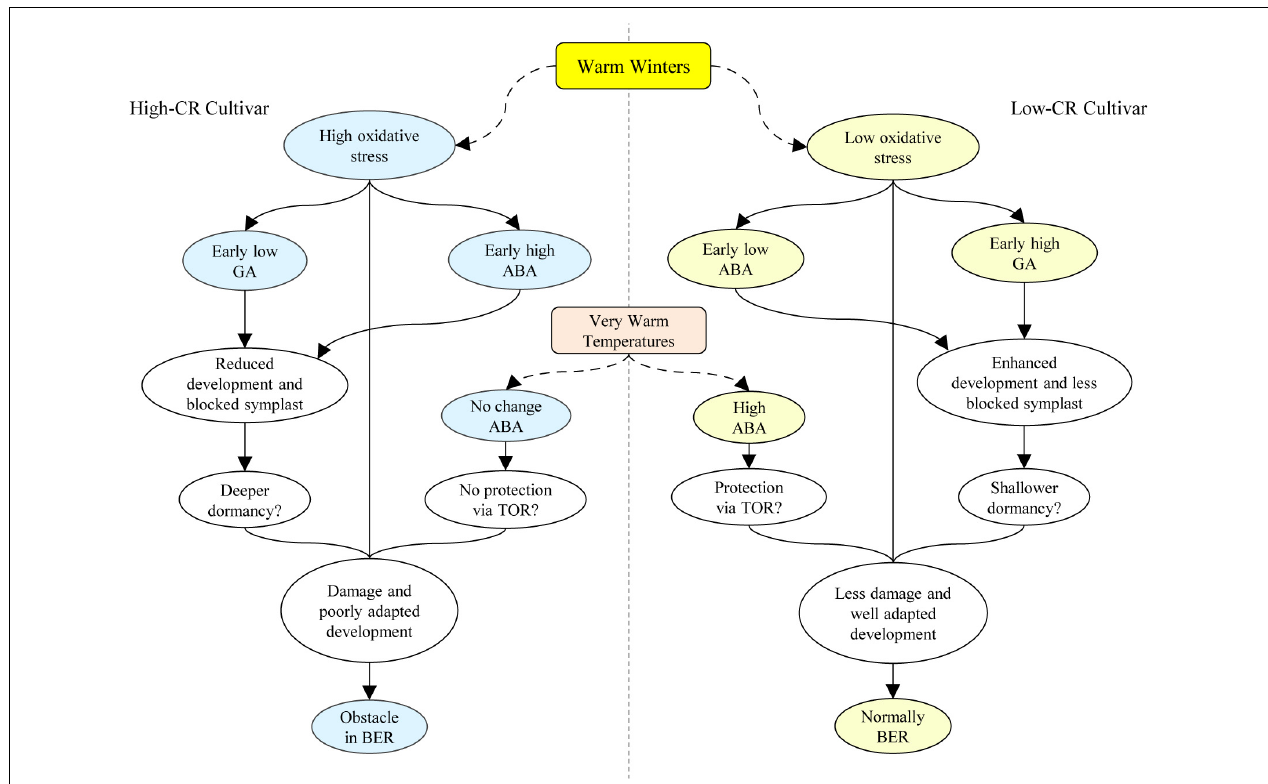
FIGURE 9 | Proposed mechanistic model for the obstacle in bud dormancy release caused by warm winters in herbaceous peony. BER, bud endodormancy